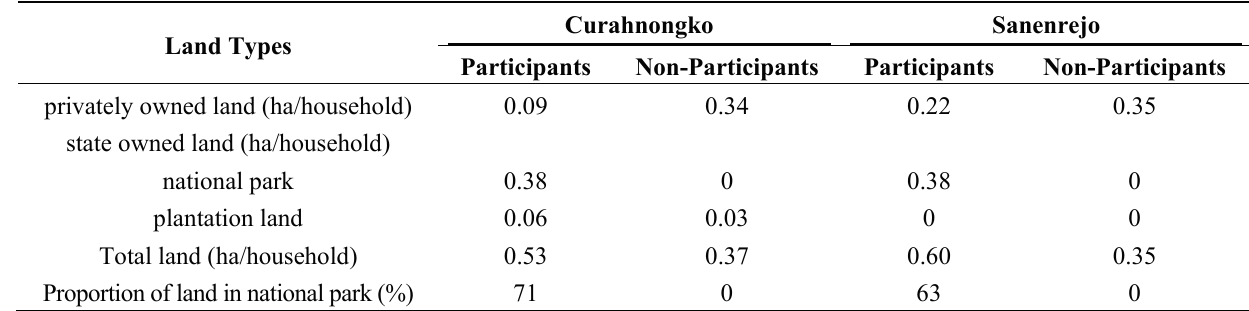
Table 1. Land area inside and outside Meru Betiri National Park.